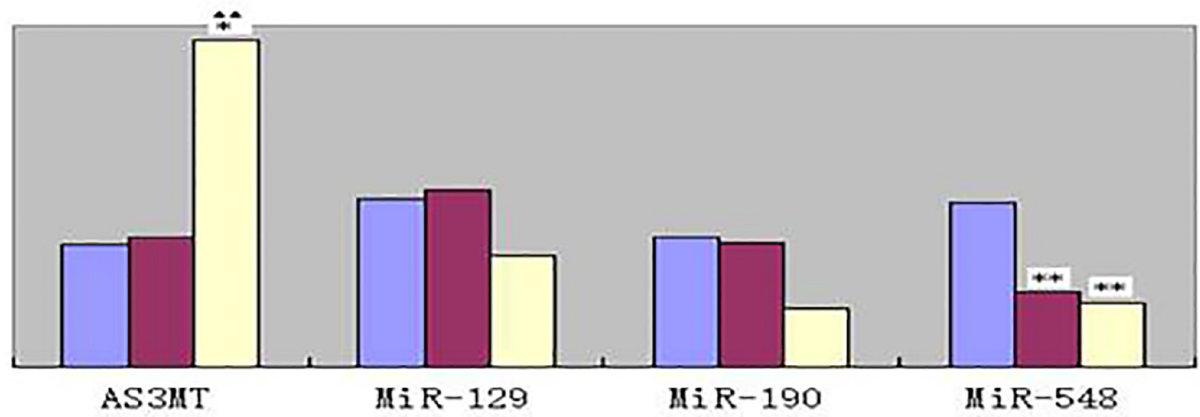
Fig 2. Relative levels of AS3MT RNA and 3miRNA selected in this study. All RNAs were selected with adjustment for age, gender, smoking status, work years, and urinary creatinine, respectively. Double stars( �� ) indicate that the difference from control group is statistically significant( P < 0.01), star ( � ) indicate that the difference from control group is statistically significant( P < 0.05), double stars( ▲▲ ) indicate that the difference from workers who stopped exposure to arsenic about 85 days (in B plant) is statistically significant( P < 0.01).